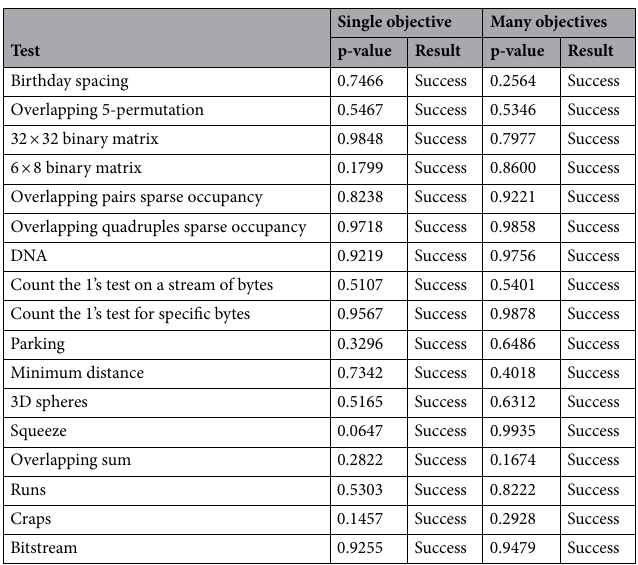
Table 2. Results from the diehard battery of tests for GE-CSPRNG with a threshold of α =